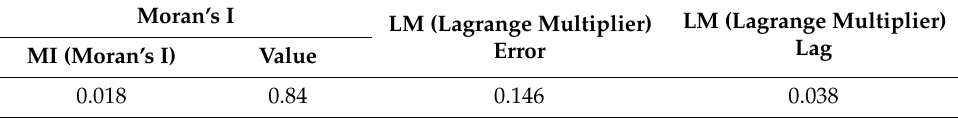
Table 2. The spatial autocorrelation of the residuals in ordinary least square (OLS).